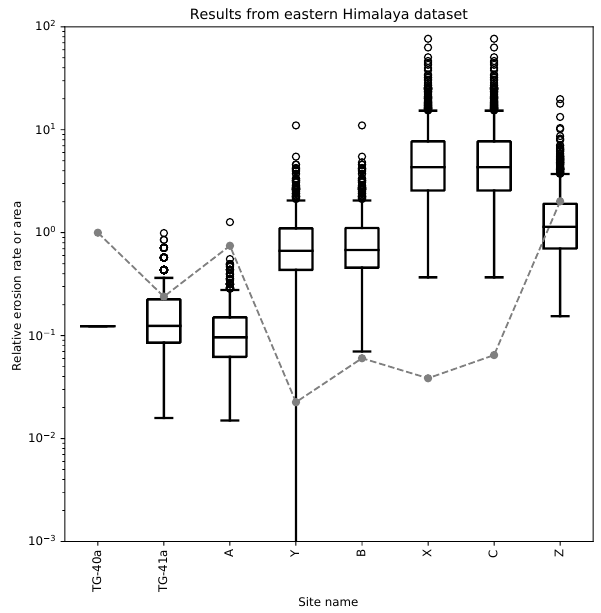
Figure 7. Computed erosion rate distributions obtained by applying the method to a Himalayan dataset. For each distribution, the box extends from the lower to upper quartile values, the line corresponds to the median value, and whiskers extend from the box to show the range of the erosion rate estimates, excluding outliers. Outliers are indicated by small circles past the end of the whiskers. Erosion rate values are normalized such that the mean is 1. The gray circles connected by a dashed gray line are the product of the imposed area and mineral concentration factors, F i = A i α i , at each site. Site names refer to locations shown in Fig.